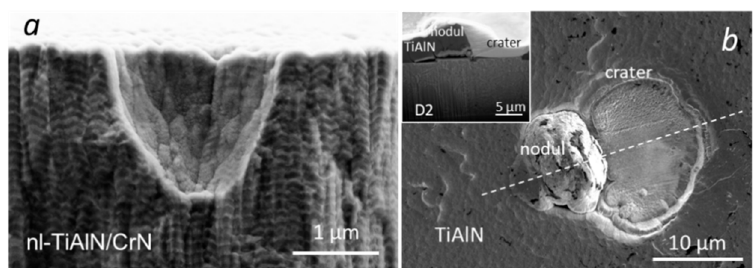
Figure 18. Crater-like defect left by the detachment of a nodule in sputter-deposited nl-TiAlN/CrN hard coating ( a ) and combination of flake and nodular defects in sputter-deposited TiAlN coating ( b